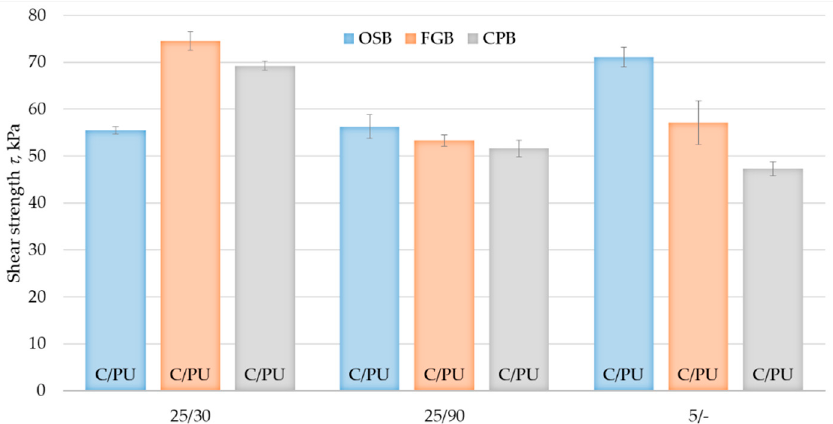
Figure 11. Shear strength tests results of bonds made under different thermal and moisture conditions. Error bars show standard deviation values. Data supplemented with a description of the damage: C/PU—damage of cohesion in PU adhesive.